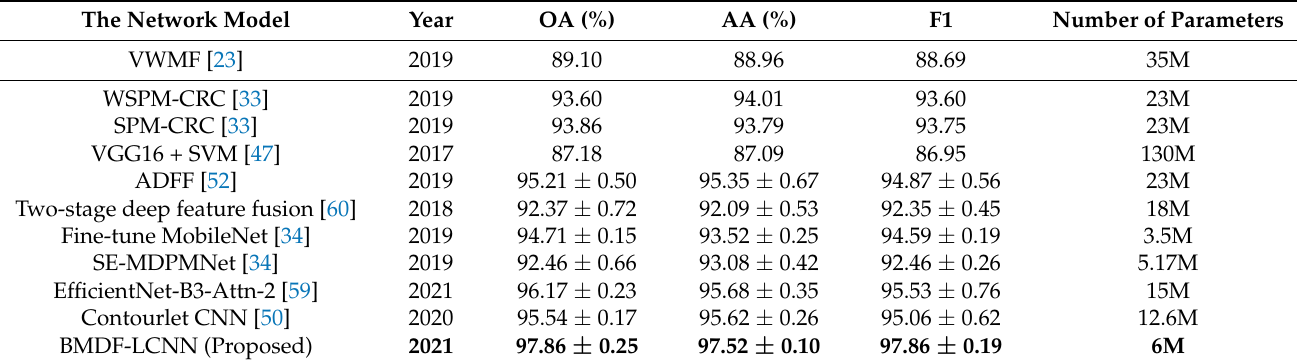
Table 5. Performance comparison of the proposed model with some advanced methods on RSSCN